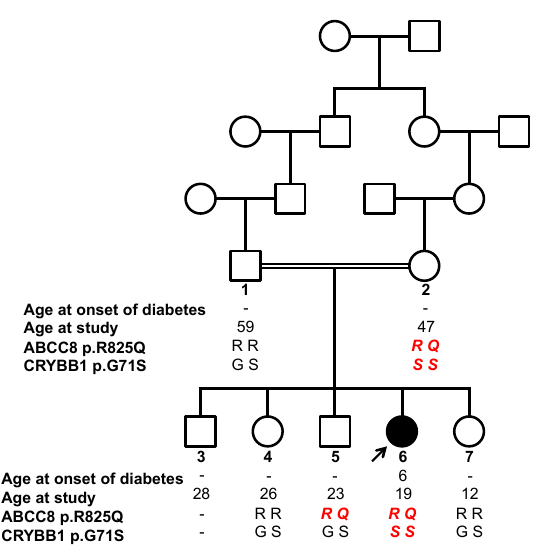
Figure 1. ABCC8 and CRYBB1 mutations in the family. Genotypes of the ABCC8 and CRYBB1 mutations (protein changes) identified by whole exome sequencing in the patient (subject 6, arrow) are shown in the whole family. Pathogenic genotypes for each gene are shown in bold red italics. Filled symbols: diabetes and cataract, empty symbols: no known diabetes and no cataract. Subject 3 was not genetically studied.